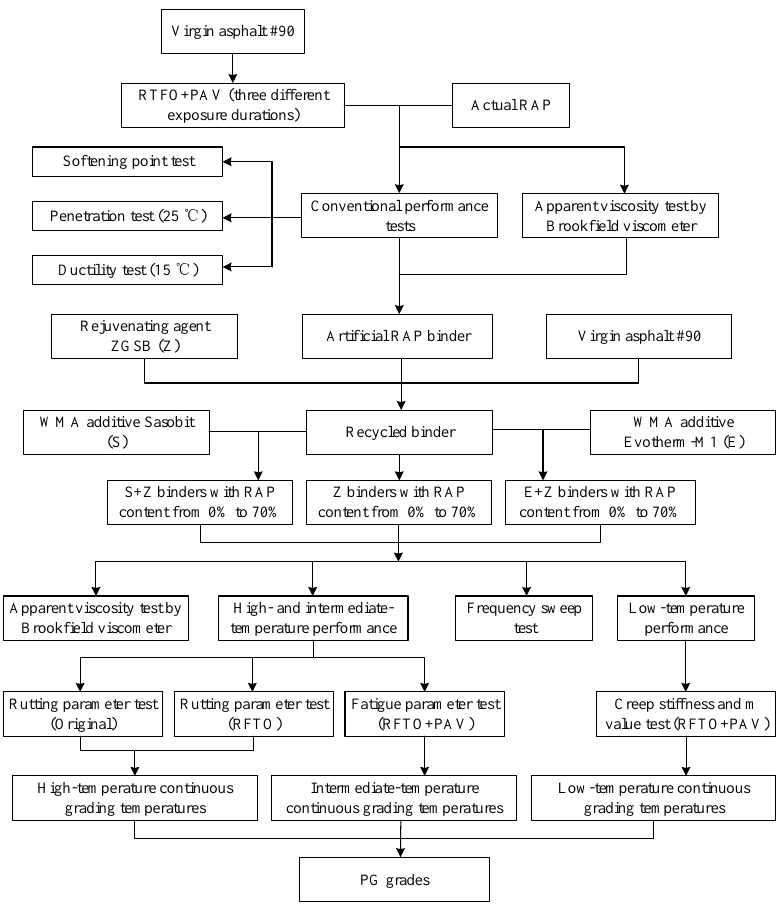
Figure 2. Flowchart of the experimental procedure.